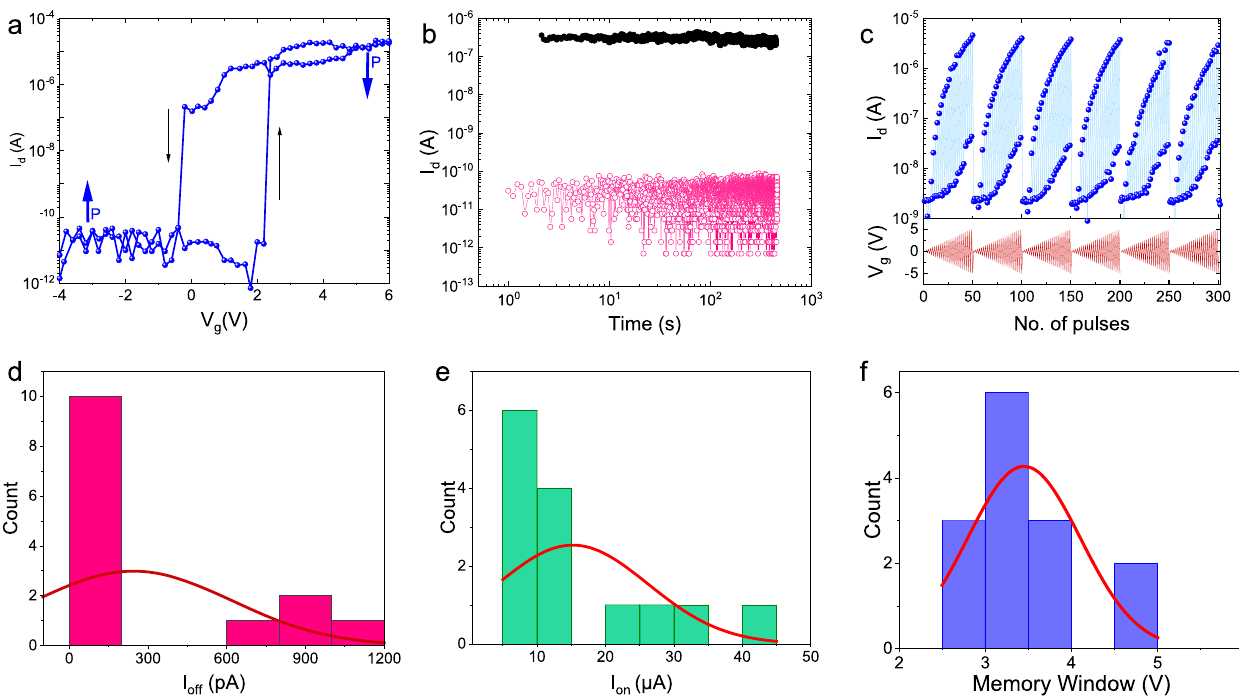
Fig. 8 Electrical measurements results of the fl exible MoS2 FeFETs. a Transfer characteristics of a typical FeFET with channel length of 2 µm and width of 5 µm, demonstrating a memory window of 3 V. b Retention characteristics of the programmed states measured after programming with + 5 V or − 3 V once followed by repeated reading cycles at 0.5 V. c Repeatability of programming of the FeFETs to multiple conductance states in response to gradually increasing magnitude of gate voltage pulses of millisecond duration. d Distribution of the memory window (MW), e I on and f I off of 14 measured devices from the 5 × 5 mm 2